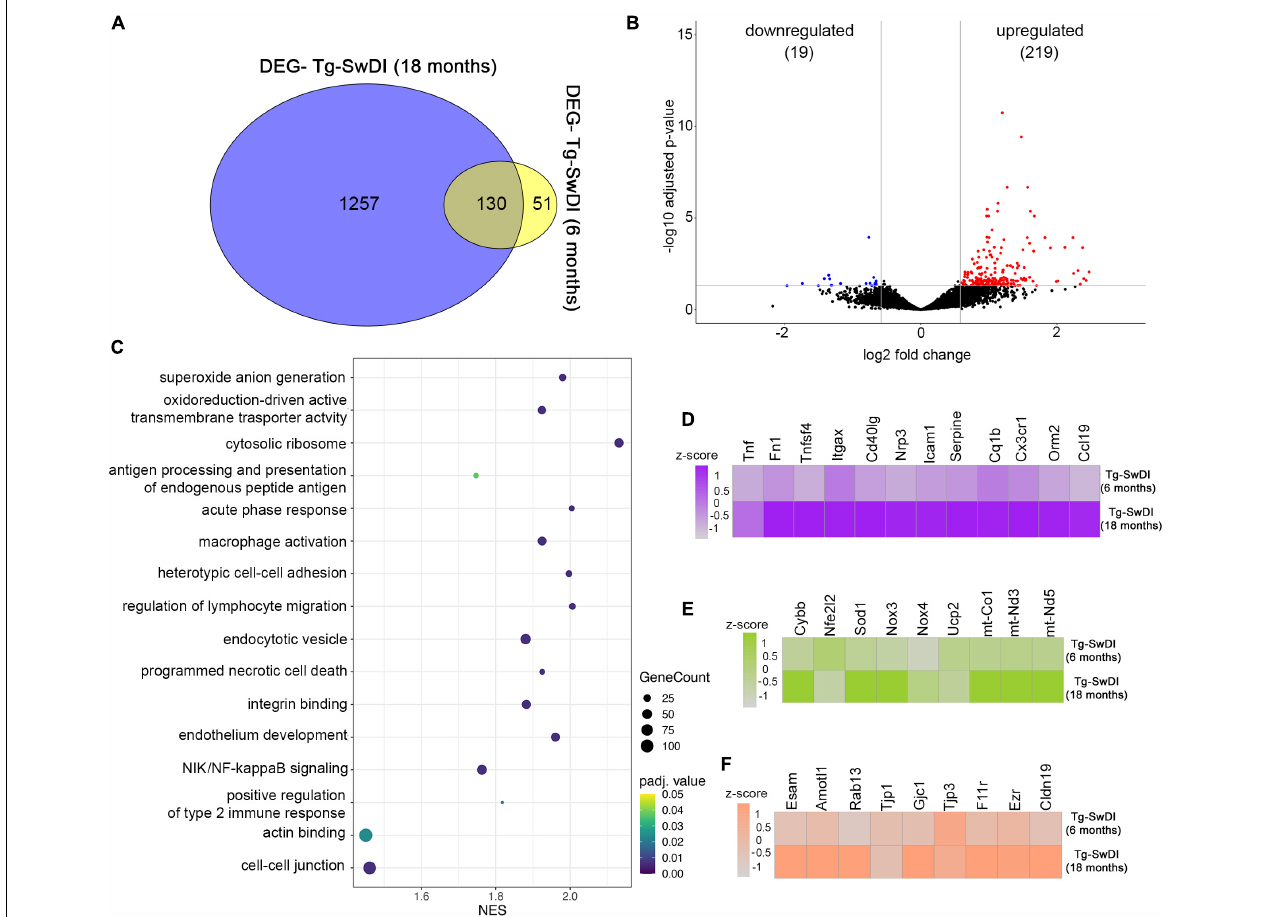
FIGURE 5 | Analysis of Gene expression in isolated microvessels of old Tg-SwDI (18 months) and young Tg-SwDI (6 months). (A) Venn diagram showing the number of DEGs among Tg-SwDI 6 months and 12 months old. Values in the intersecting regions represent the number of overlapped DEGs between the comparisons, and values in the non-intersecting regions represent the number of DEGs that were unique to the corresponding comparison. (B) Volcano plot shows differentially expressed genes (DEGs) in Tg-SwDI (18 months) compared with Tg-SwDI (6 months). Red points are up-regulated genes, blue points are down-regulated genes, and black points are genes with no significant difference. The x - and y -axes show log2 fold change and − log10 p -value, respectively. (C) Gene set enrichment analysis demonstrates the top 20 enriched GO terms in Tg-SwDI (18 months) compared with Tg-SwDI young (6 months). The listed gene sets belong to all GO categories (biological process, cellular compartment, and molecular function). NES, normalized enrichment score. The node size represents the gene count. The color intensity represents p -adjusted value < 0.05. (D–F) Heat maps show the genes differentially expressed in microvessels isolated from Tg-SwDI (18 months) compared with Tg-SwDI (6 months). Heat maps for the differential expression of genes related to inflammation (D) , oxidative metabolism (E) , and junction proteins (F) are shown. The color scale represents the row z -scores of normalized gene